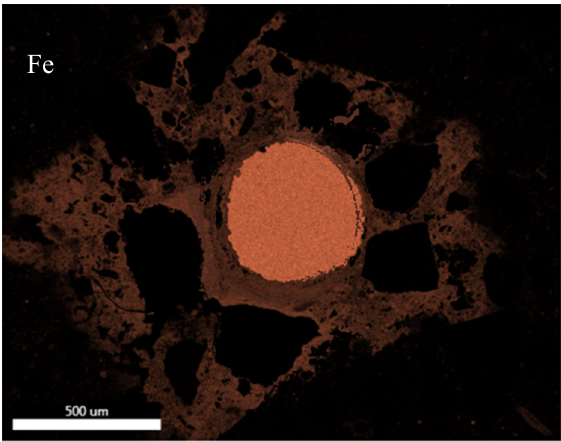
Figure 6. Iron mapping by SEM/EDX samples of a cut section of steel wire (diameter 0.5mm) embedded in a carbonated mortar (binder CEM II/B‐M (T‐LL), w/b ratio 0.6) and exposed to 99% RH for 1